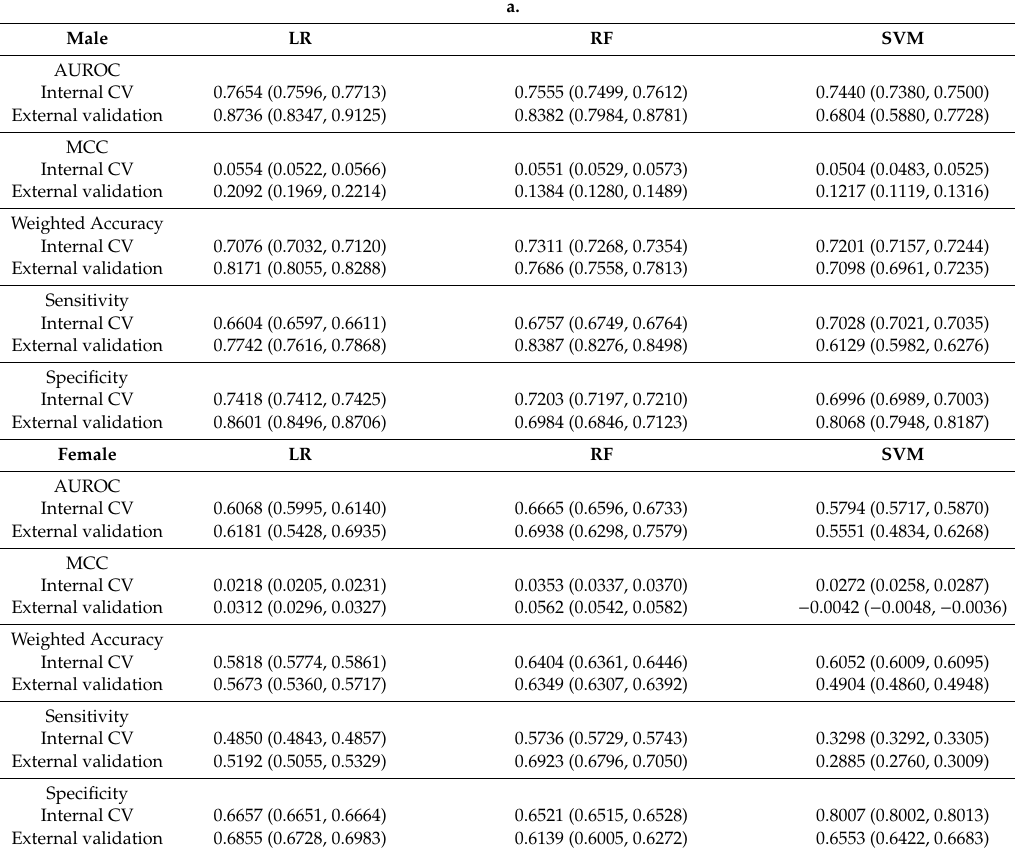
Table 2. a. Performance of cancers screening algorithms. b. Performance of screening top three types